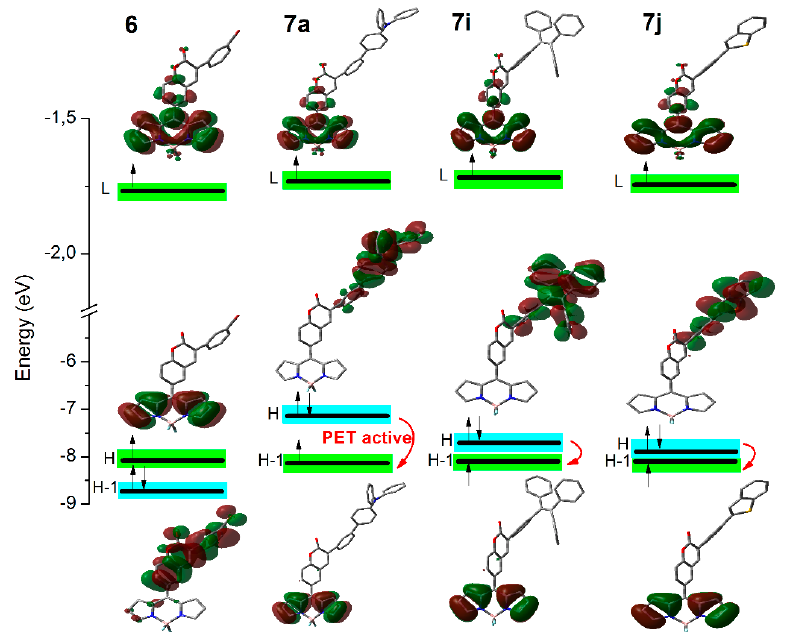
Figure 4. Main calculated molecular orbitals from the optimized geometries (wb97xd / 6-311 + g*) of the dyads with π -extended coumarins 7a, 7i and 7j , compared with those computed for the dyad bearing the simplest coumarin 6, to illustrate the viability of the electron transfer upon selective excitation of the BODIPY in the former dyads.